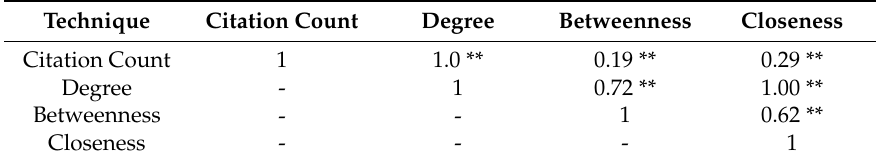
Table 11. Kendall correlation between degree, betweenness, closeness and citation count. Technique